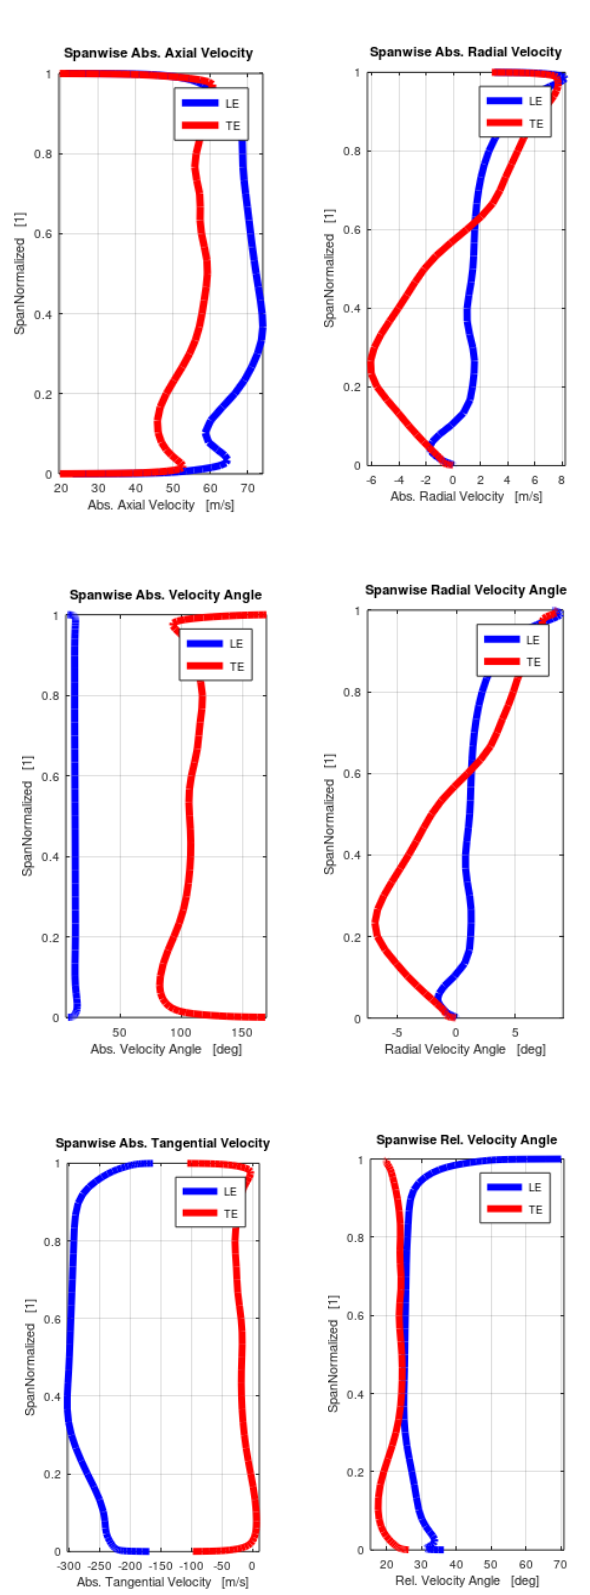
Fig. 6. Variation of the averaged components of the velocity vector along the span of the rotor blade at the leading edge and the trailing edge.